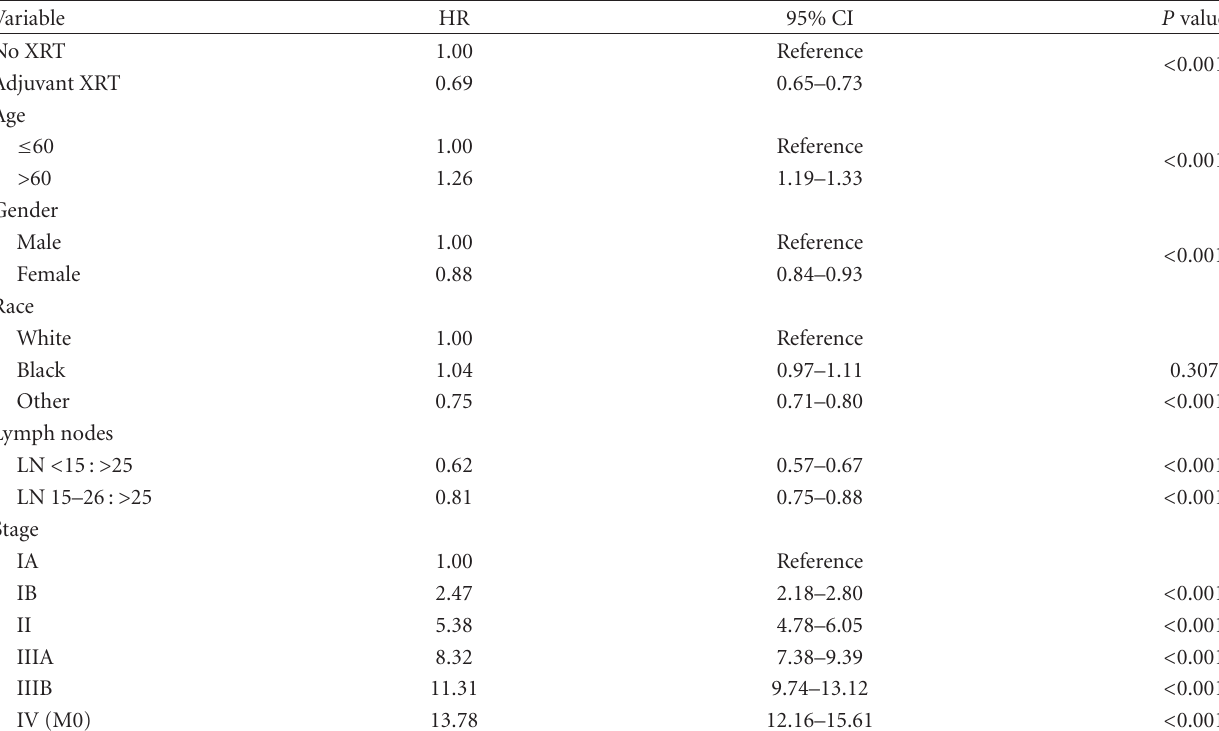
Table 4: Cox multivariate regression analysis for disease-specific